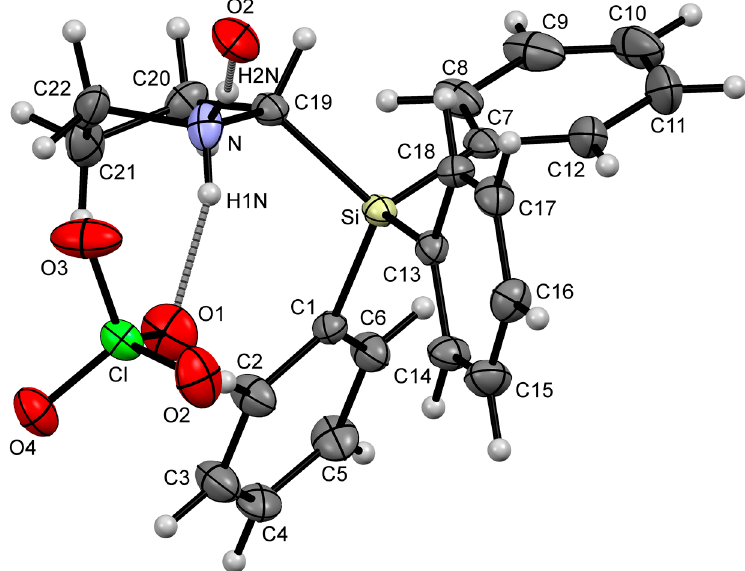
Figure 2. Part of the crystal structure (ORTEP plot) of compound ( S )- 1 ·HClO 4 in the crystal, with the displacement ellipsoids set at the 50% probability level. Selected bond lengths (Å) and angles (°):